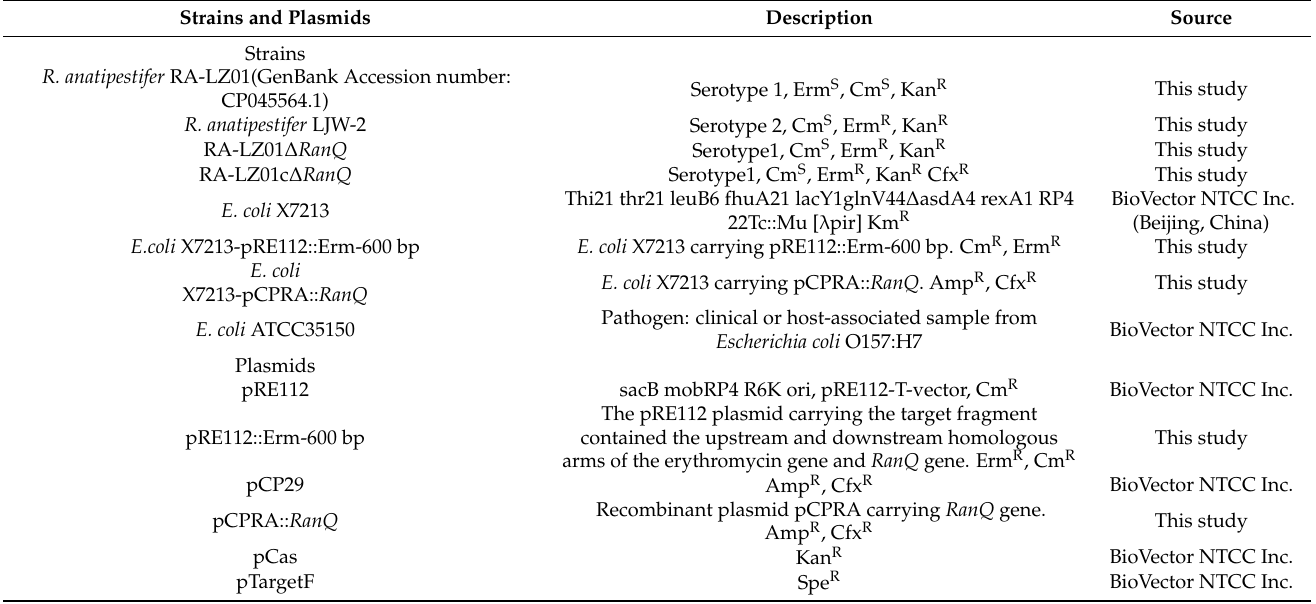
Table 1. Bacterial strains and plasmids used in this study.